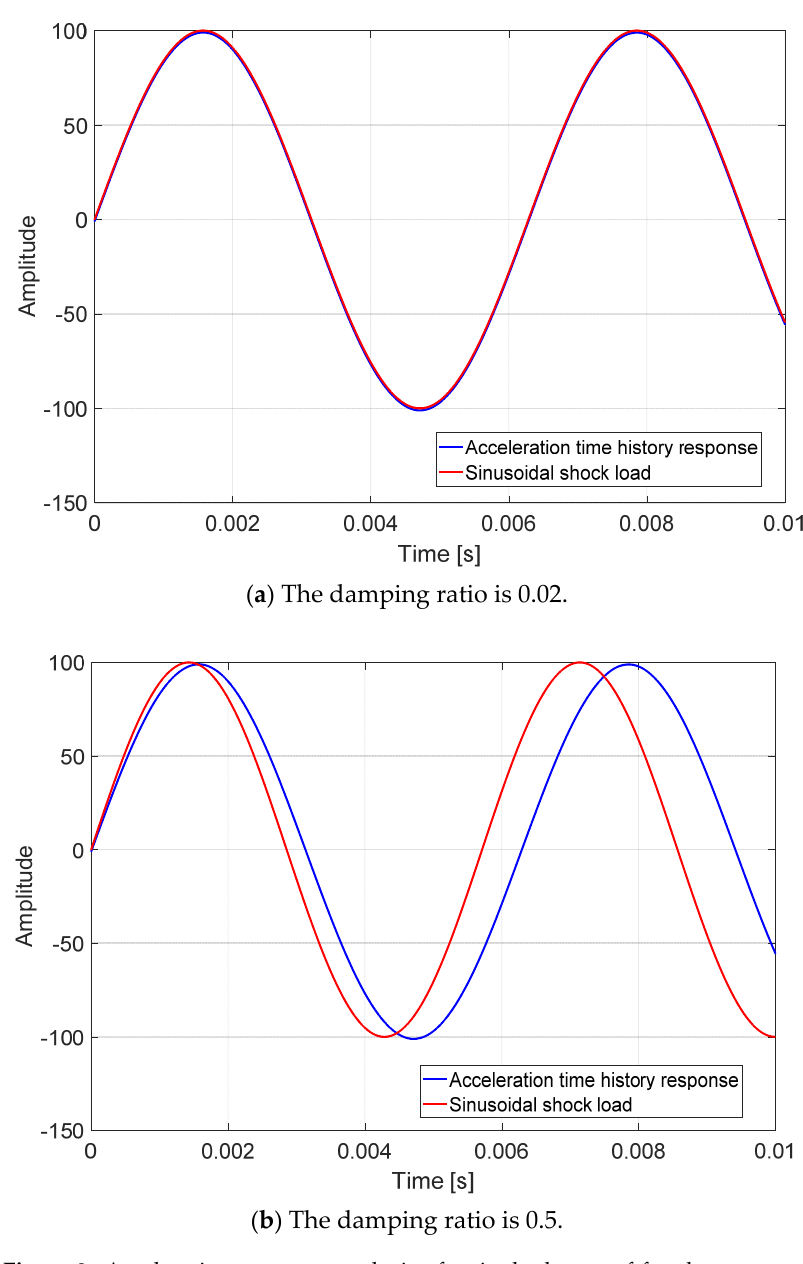
Figure 2. Acceleration response analysis of a single-degree-of-freedom system under sinusoidal shock loading.